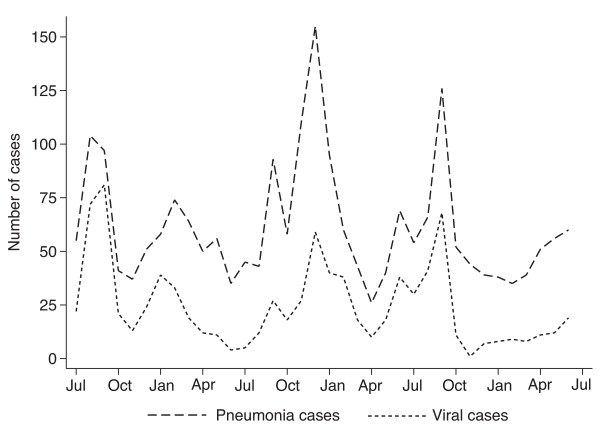
Monthly number of community-acquired pneumonia cases and cases with a positive virus PCR in children aged 2 to 35 months identified at a field clinic in Bhaktapur, Nepal, from July 2004 to June 2007.